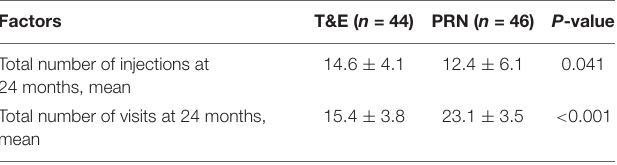
TABLE 1 | Baseline characteristics between T&E and PRN group. TABLE 3 | The number of injections and visits at 24 months.